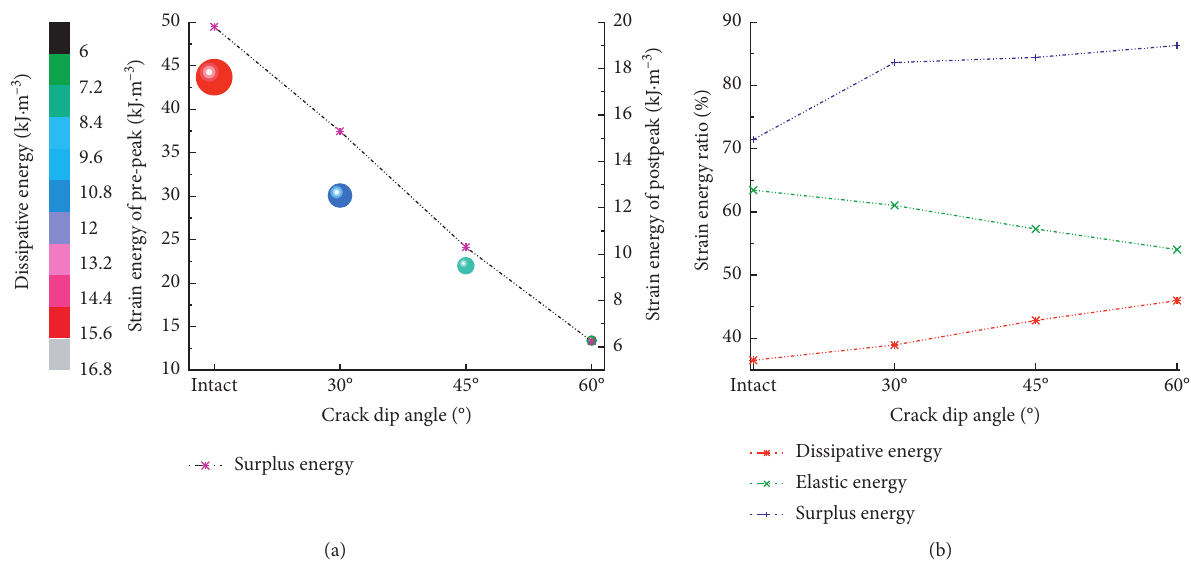
Figure 6: Curves depicting the relationship between the strain energy and precrack dip angle in typical intact and precracked rock specimens: (a) peak strain energy and (b) strain energy ratio